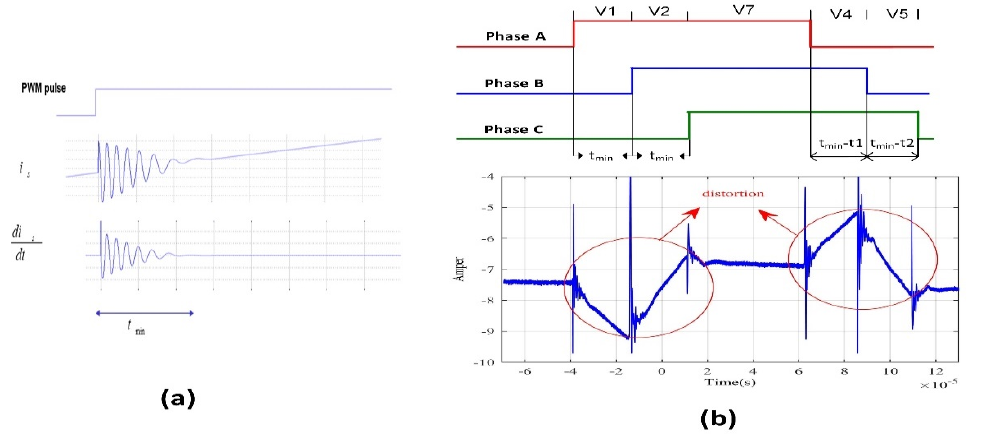
Figure 16. ( a ) HF oscillations when IGBT switches state, and ( b ) dynamic current response.